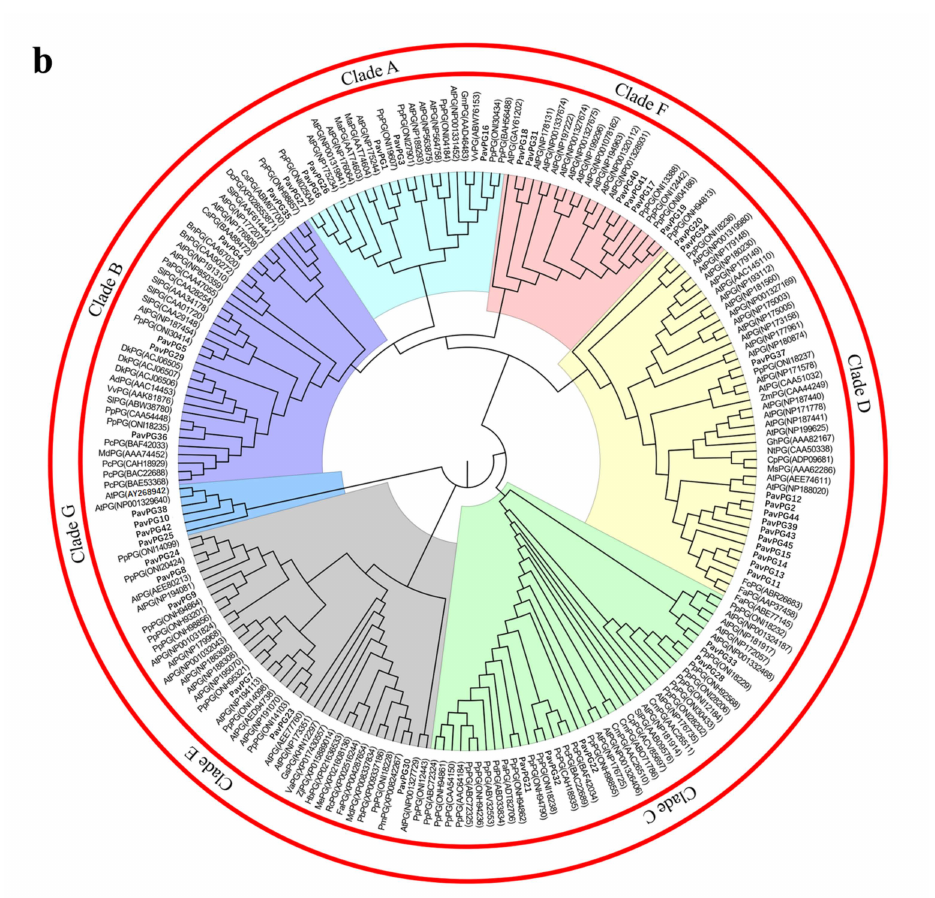
Figure 1. Phylogenetic relationship of XTHs ( a ) and PGs ( b ) from sweet cherry and other plants. The phylogenetic tree was constructed using MEGA 6.0 by the Neighbor-Joining method. The protein sequences of XTHs and PGs gene family members from other plants were retrieved from the GenBank database and the gene accessions are presented in the